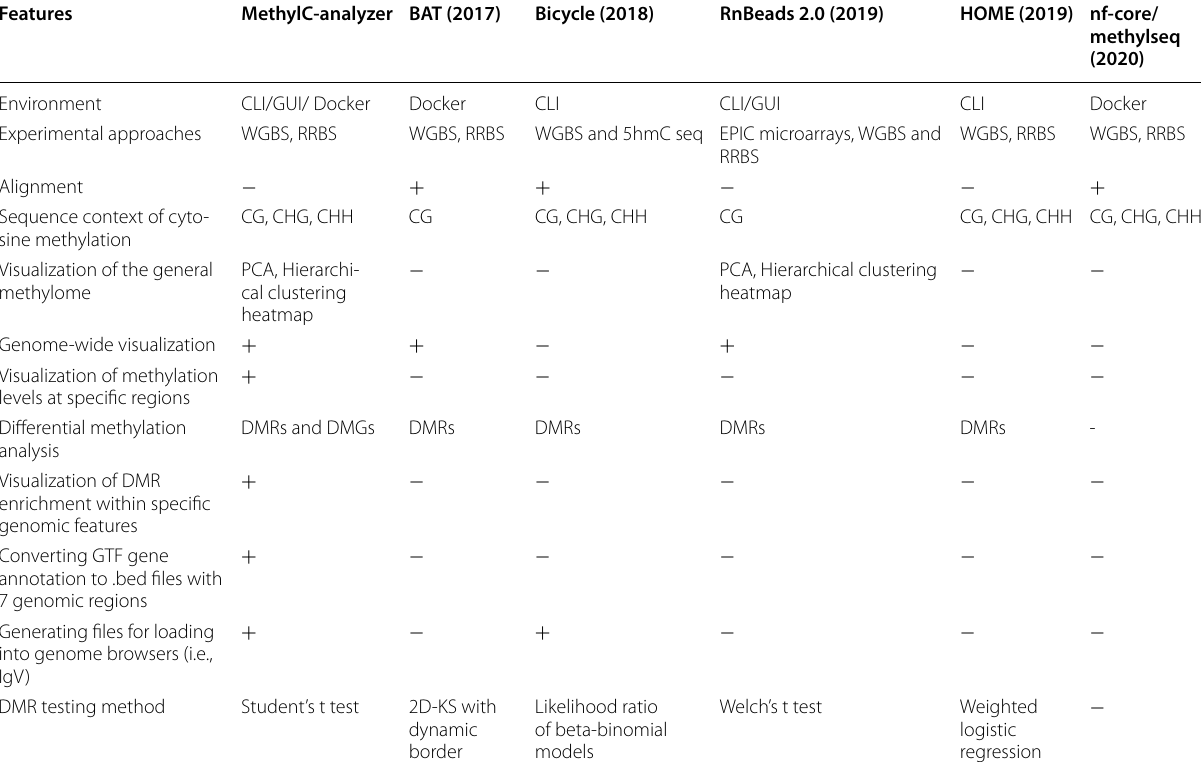
Table 1 Comparisons of MethylC‑analyzer with other methylation analysis tools